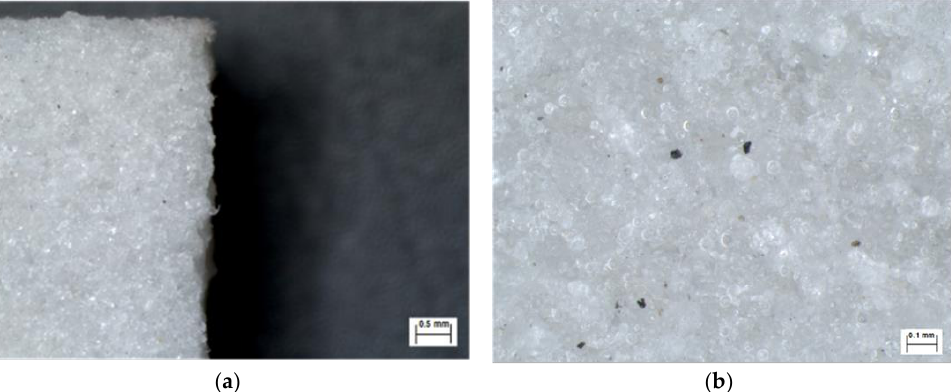
Figure 7. Scanning electron micrographs for 30% blend of: ( a ) the break edge; and ( b ) the material surface structure; black patches represent inclusion of diatomaceous earth in the blend.Upon visual analysis, the pure nylon-11 in Figure 5 shows the apparent fibers that have been elongated at the break. The material is stretched at the line of break and the break surface is pretty rough and jagged. This is due to extreme plastic deformation under the test loading.